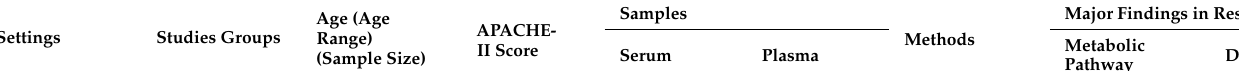
Table 5. Metabolomics-assisted treatment monitoring in patients with sepsis/septic